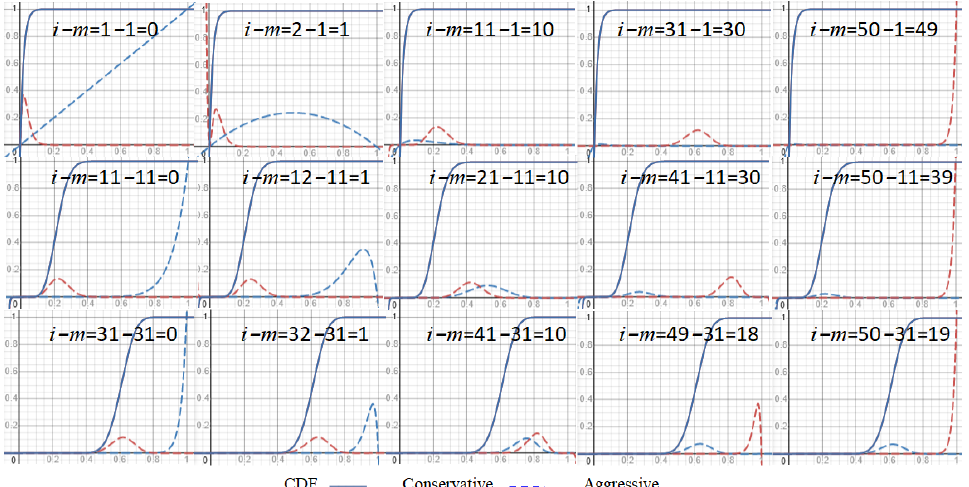
( i − 1 ) u m ( 1 − u ) i − m , and aggressive GPoW, i = m m − 1 ) u m ( 1 − u ) i − m and Aggressive = m − 1